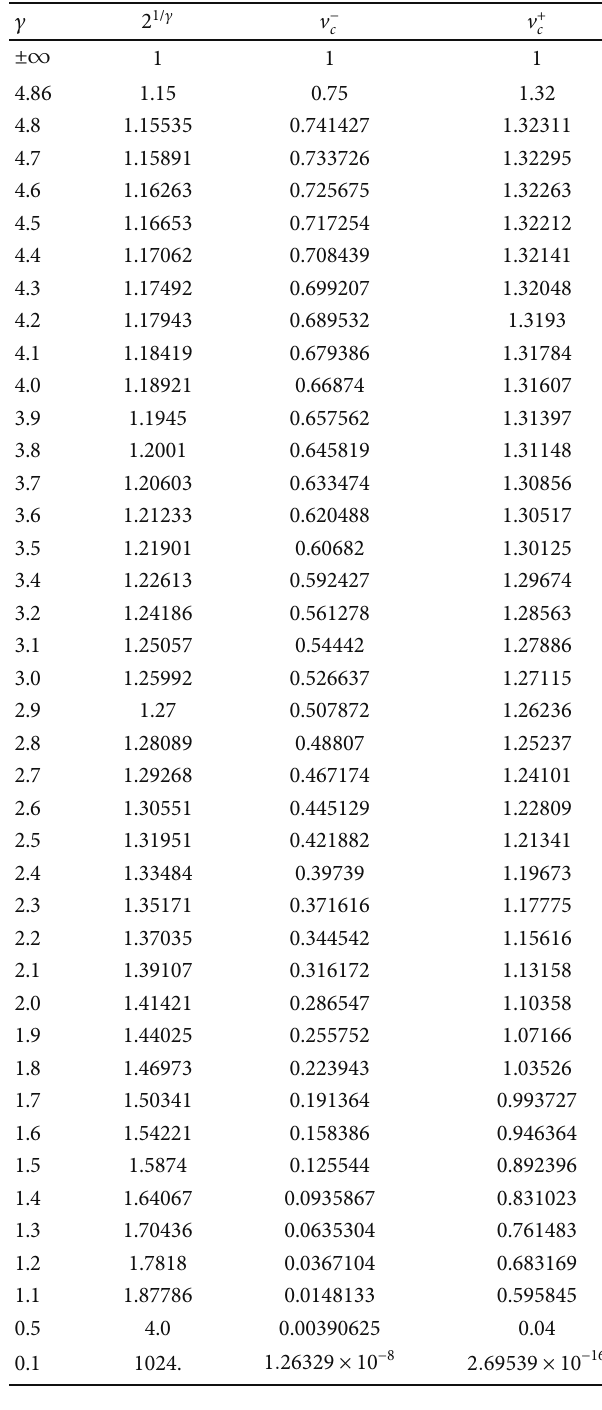
Table 2: Critical speci fi c volume for large v + generalized ABG black